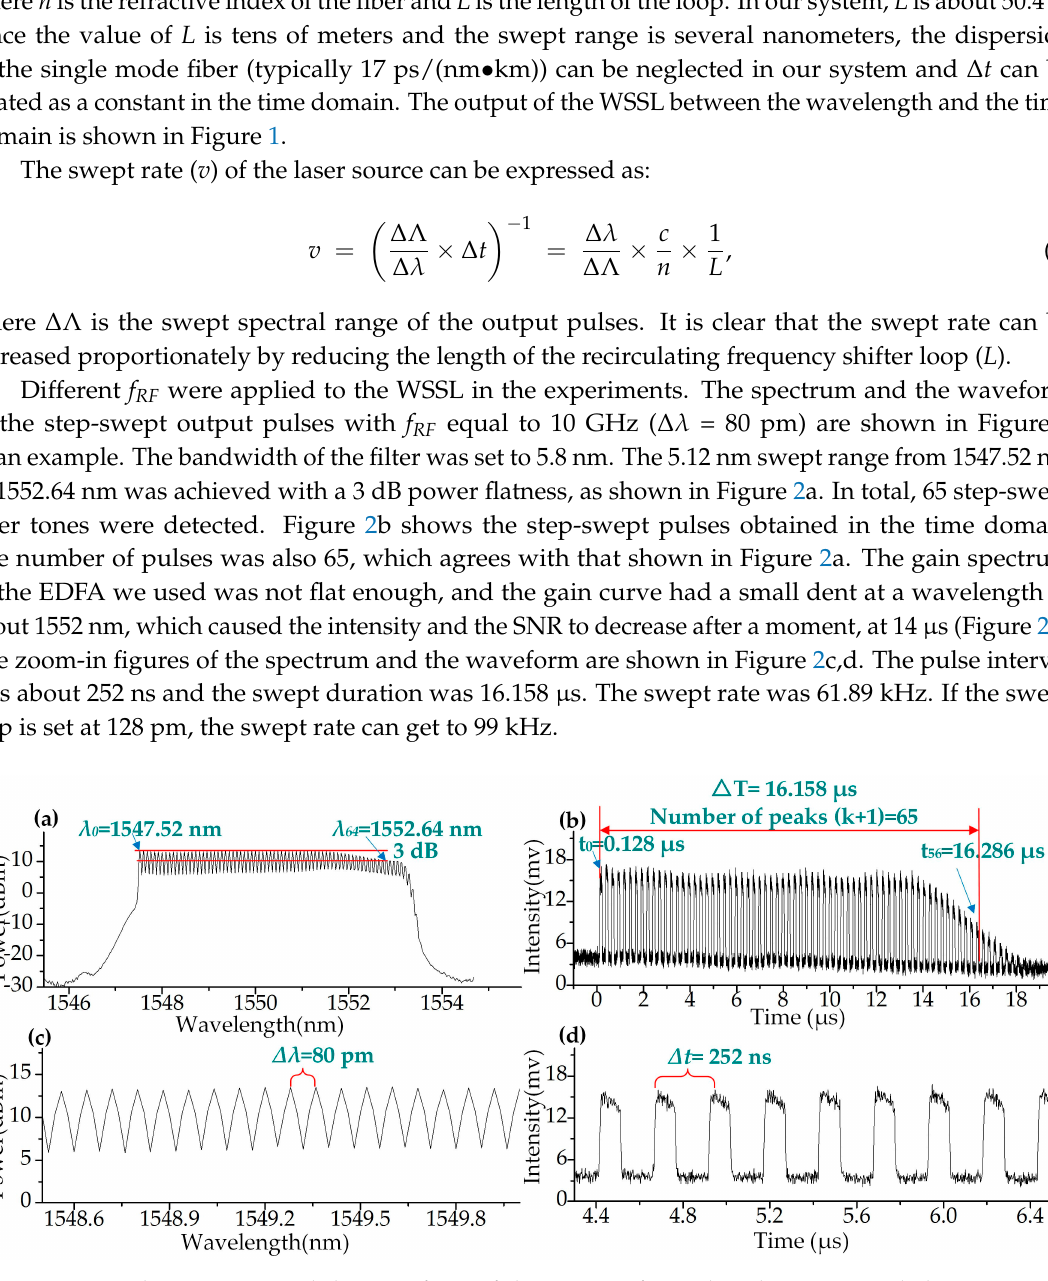
Figure 2. The spectrum and the waveform of the output of wavelength step-swept light source ( f RF = 10 GHz). ( a ) Spectrum in wavelength domain. ( b ) The waveform in time domain. ( c ) The zoom-in figure of the spectrum. ( d ) The zoom-in figure of the waveform.